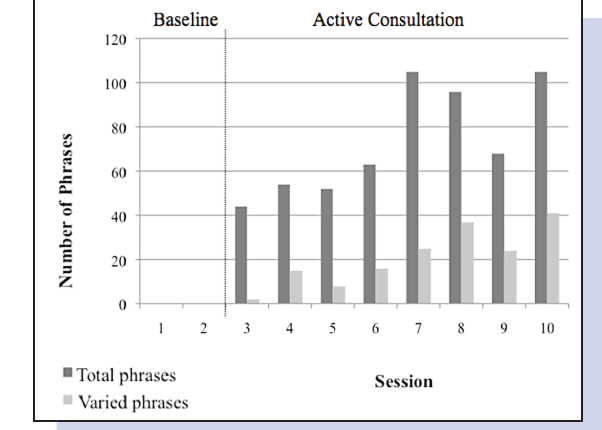
Figure 2. Total Number of Phrases and Varied Phrases Produced by the Clinician